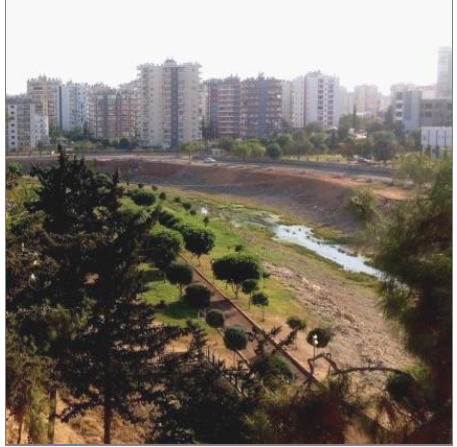
Figure 4 Changing urban silhouette with new construction in Yenişehir